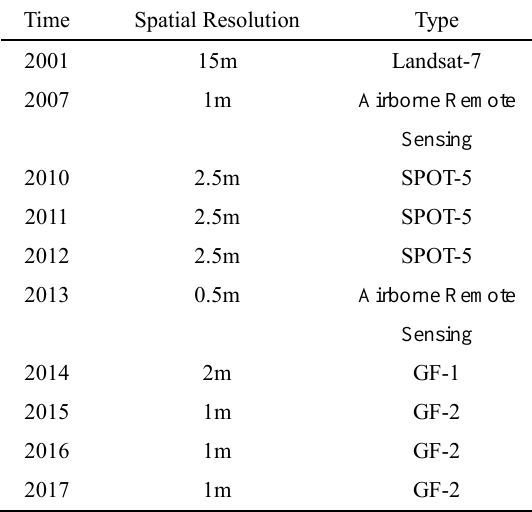
Table 1 Introduction of remote sensing image from 2001 to